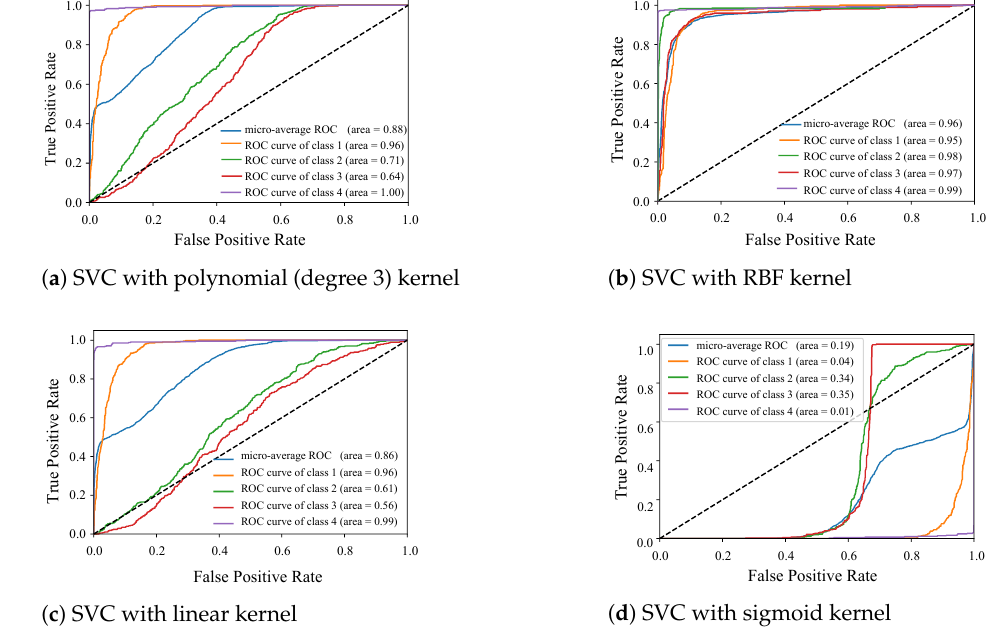
Figure 4. SVM of the measured data into four shap categories using different kernel functions.